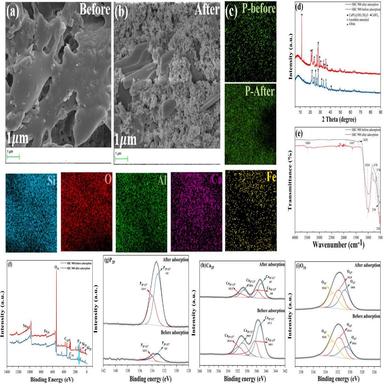
Characterization results of ceramsite SBC 900 before and after adsorption: (a)~(c) SEM and EDX results, (d) XRD patterns, (e) FTIR spectra, (f)~(i) XPS spectra.